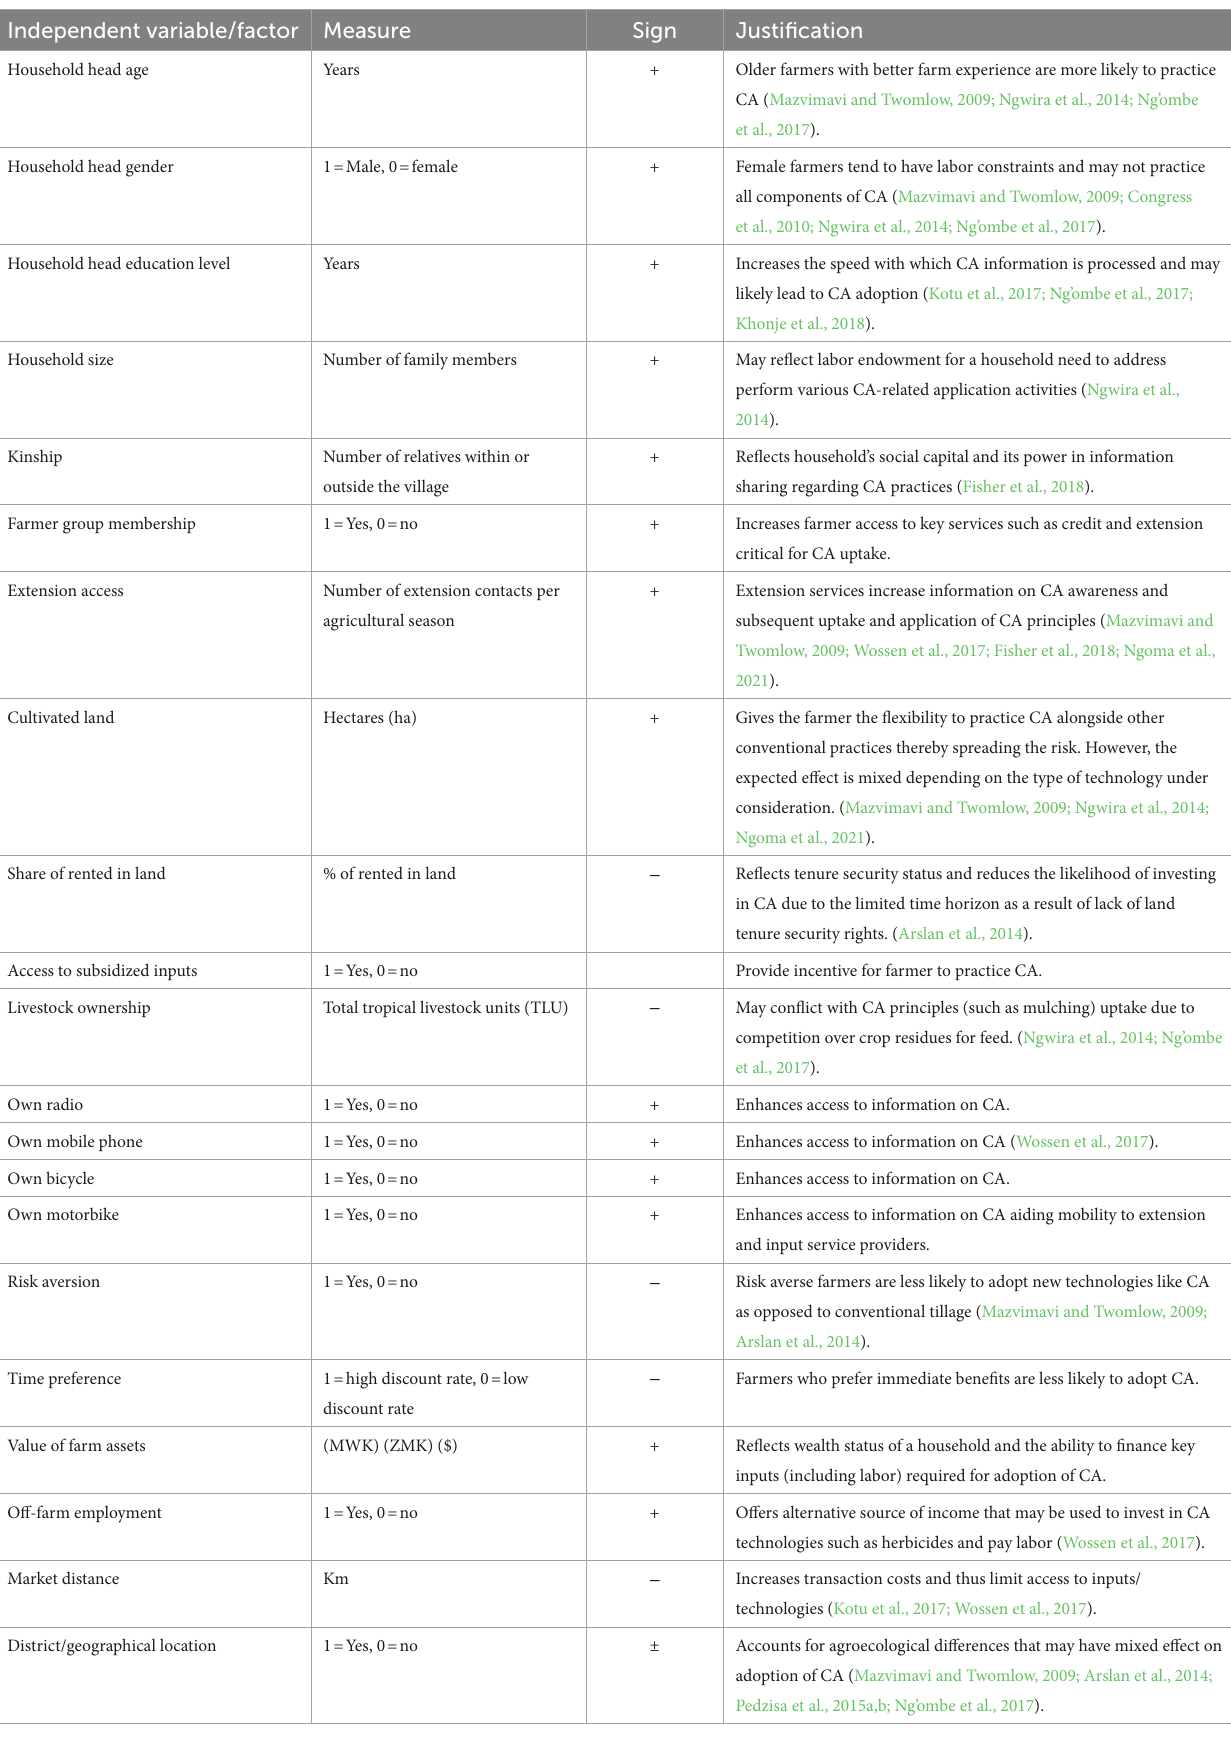
TABLE 2 Hypothesized determinants/factors influencing adoption of CA in southern Africa. Independent variable/factor Measure Sign